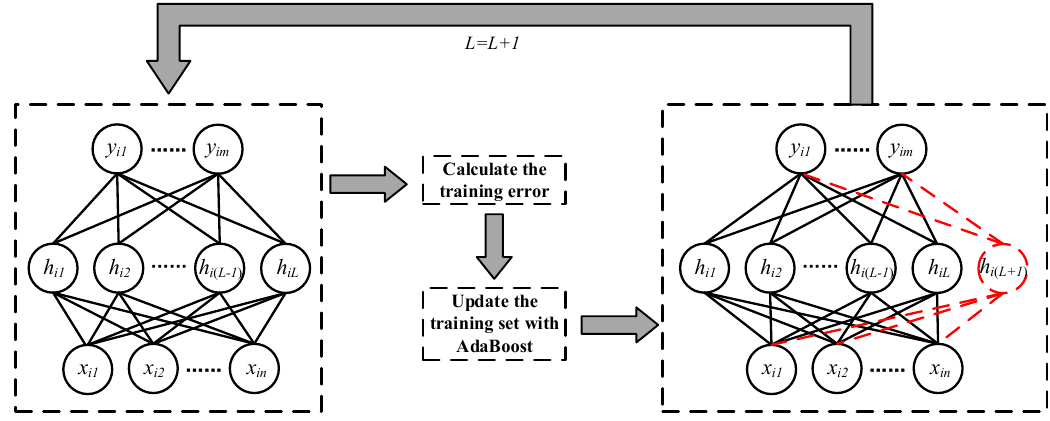
Figure 3. The flow of AdaBoost-SCN method.